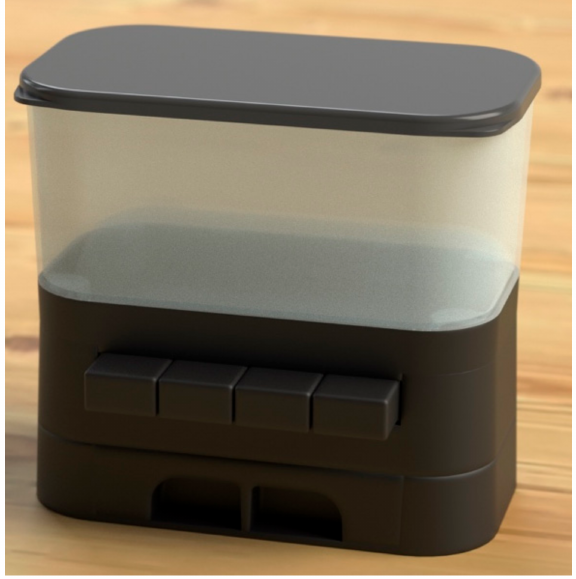
Figure 1. Salt Control H